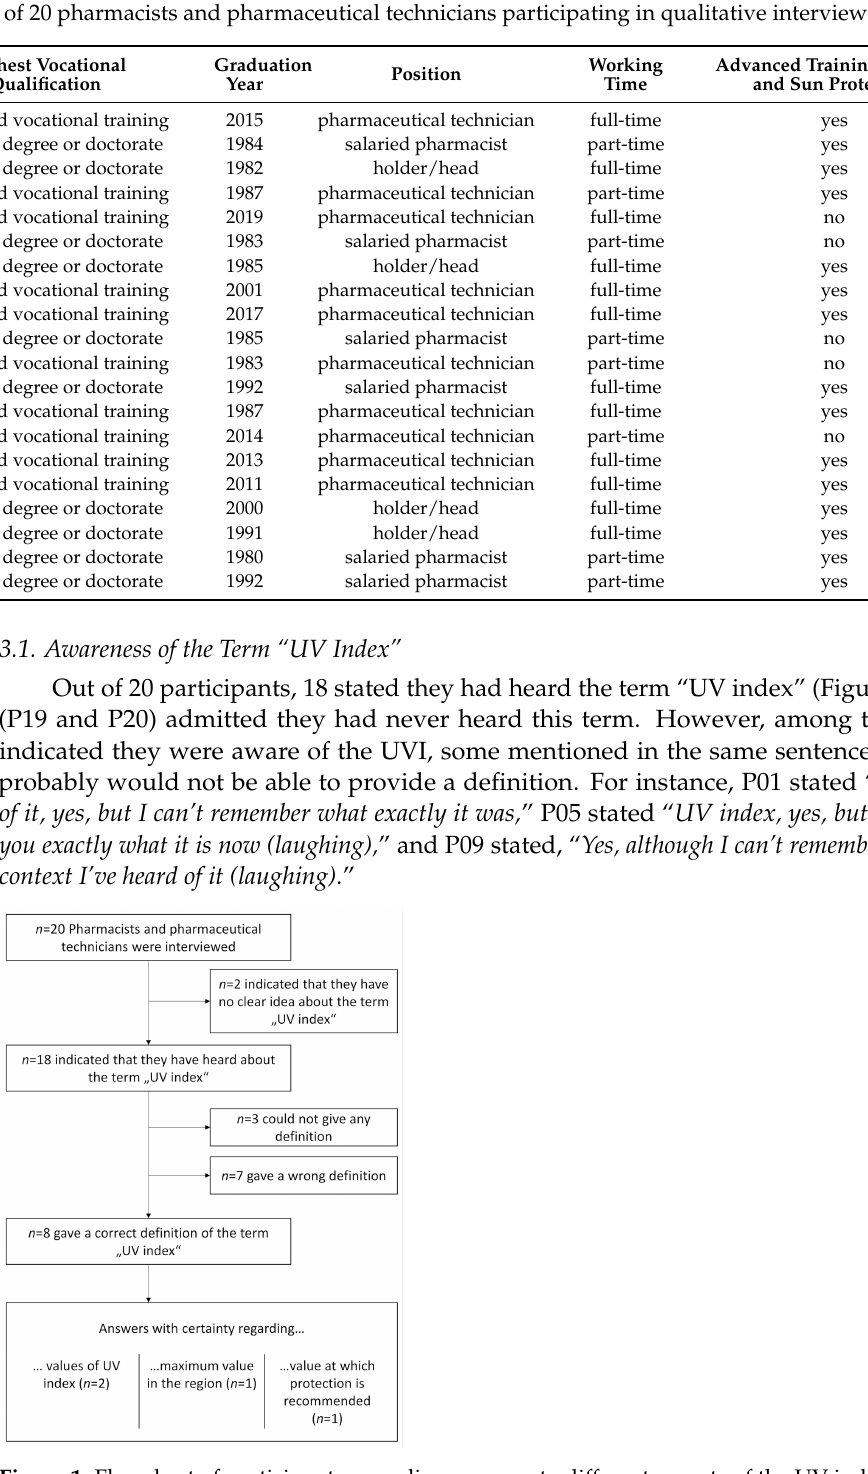
Figure 1. Flowchart of participants regarding answers to different aspects of the UV